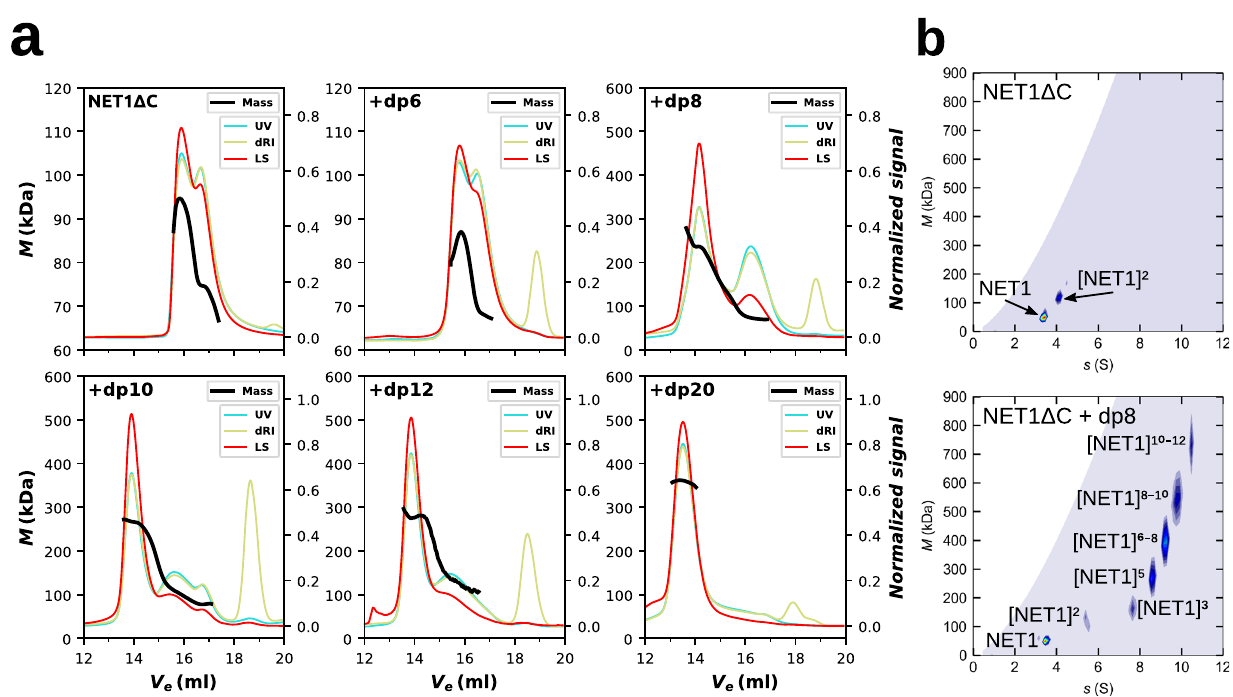
Fig. 4 | Dynamic nature of NET1 Δ C - SEC-MALS and analytical ultracentrifuga- tion. a SEC-MALS analysis of NET1 Δ C in absence of HOs shows an equilibrium betweenmonomericand dimeric NET1 Δ C. Uponthe additionof HO-dp8, HO-dp10 and HO-dp12 we see a step-wise increase of mass with growing HO length. In the presence of HO-dp20, NET1 Δ C forms a higher-order oligomer with a calculated mass of 346kDa. Black lines show the mass distributions across the elution peaks which were traced by UV ( A 280nm , cyan), differential refractive index